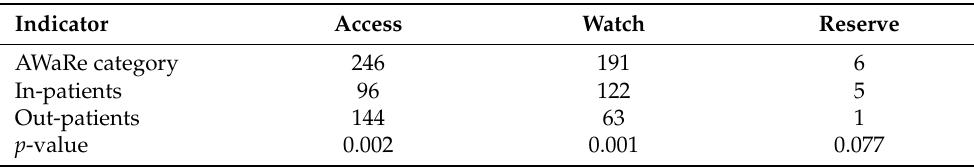
Table 3. Distribution of prescribed antibiotics according to the WHO AWaRe classification for in- and out-patients.